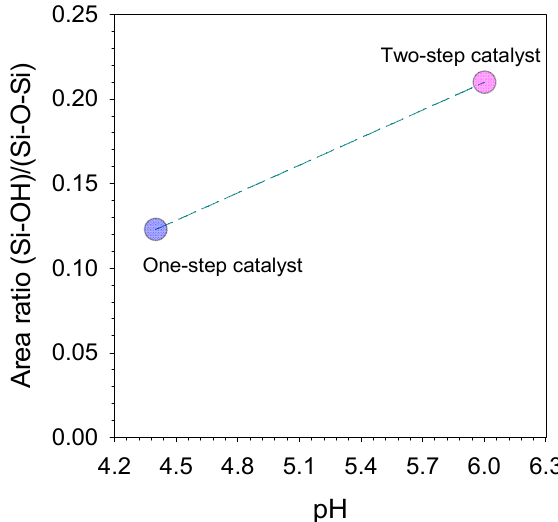
Figure 3. Deconvoluted peak area ratios of silanol/siloxane (940 cm − 1 )/(1070 cm − 1 ) as a function of pH to perform various one-step catalyst (citric acid) and two-step catalyst (acid-base)